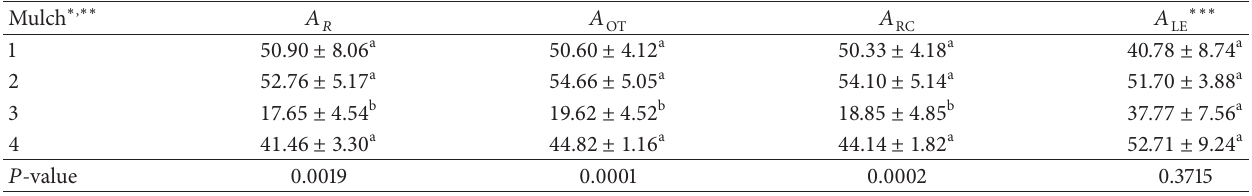
Table 4: Comparison of mulch deterioration by percentage of bare soil area (% of white pixels) ± standard error in binary images obtained by thresholding methods: Otsu (OT), Ridler-Calvard (RC), and local entropy (LE). The areas obtained based on the reference images ( 𝐴 𝑅 ) are shown in the first column. Mulch materials: biodegradable (BD), polyethylene (PE), and paper (PP). Mulch ∗ , ∗∗ 𝐴 𝑅 𝐴